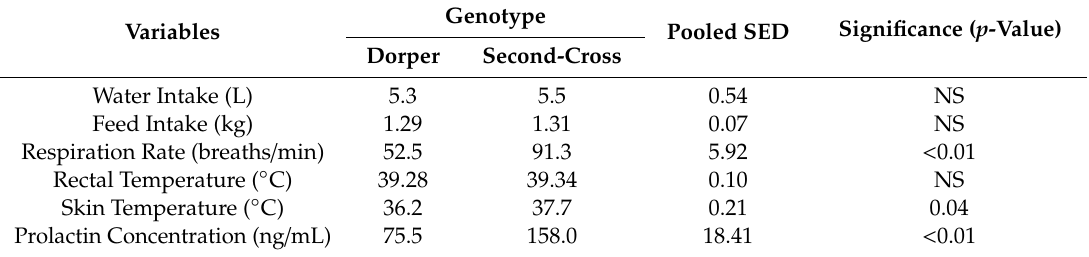
Table 1. Mean ( ± SED) physiological parameters in Dorper and second-cross (SC) lambs prior to the imposition of thermoneutral (TN) and heat stress (HS) treatments ( n = 24 / genotype). Variables